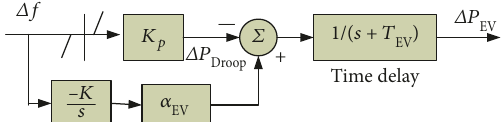
Figure 3: Static frequency control model for electric